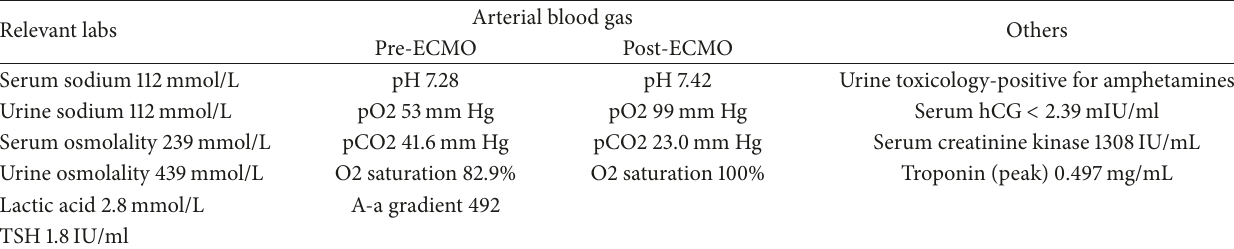
Table 1: Laboratory